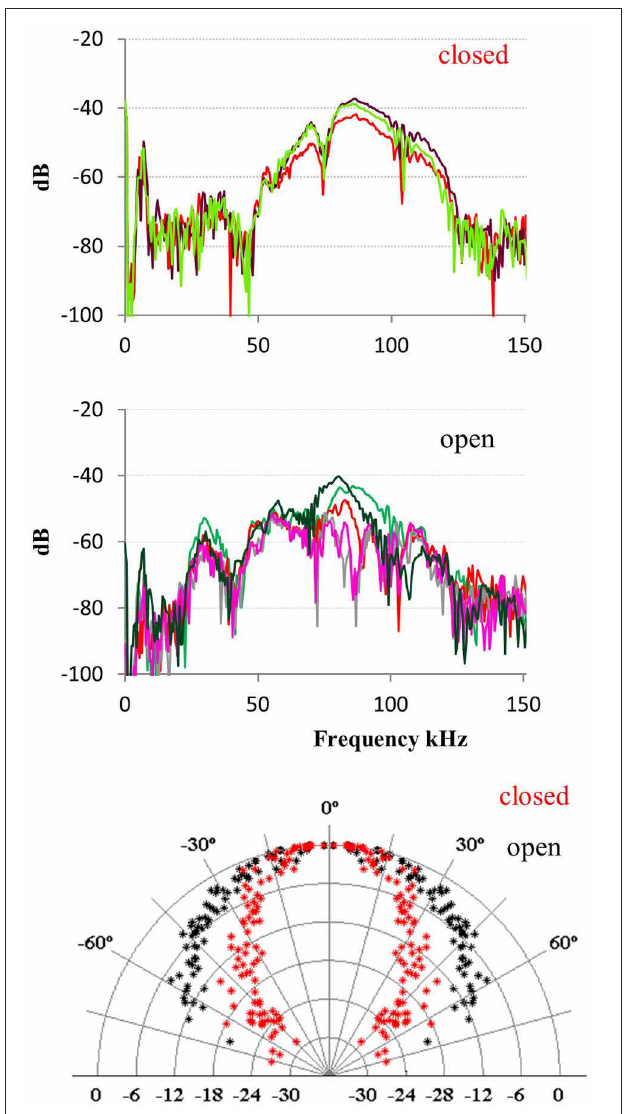
FIGURE 5 | Calls emitted with closed and open mouth. When one of the bats recorded in 2008 emitted calls with closed mouth (upper panel) it had most energy in the third harmonic ( F peak 90kHz) and some in the second and fourth harmonic. When it emitted calls with open mouth (middle panel) it also emitted substantial energy in the first harmonic ( F peak 30kHz). The effect of this was that the bat added a component with broad directionality (lower panel, black data points) when it called with the mouth open, compared to the directionality calculated for closed mouth calls with most energy around 90kHz (red